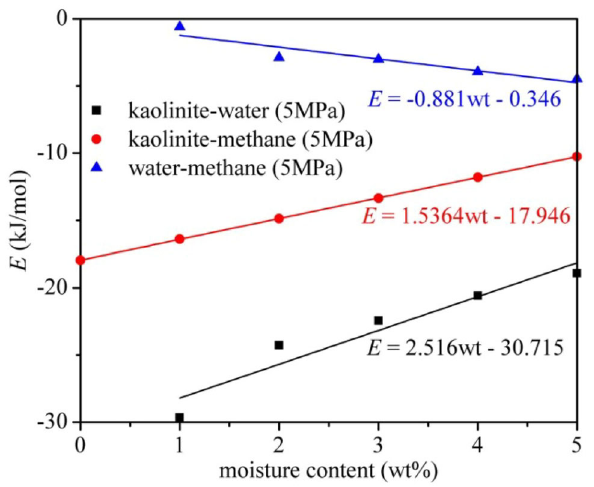
Fig. 9 Interaction energy of CH 4 –kaolinite, water–kaolinite, CH 4 – water, and CH 4 –CH 4 for moist kaolinite with 3 wt% water at 293.15 K and 5 MPa